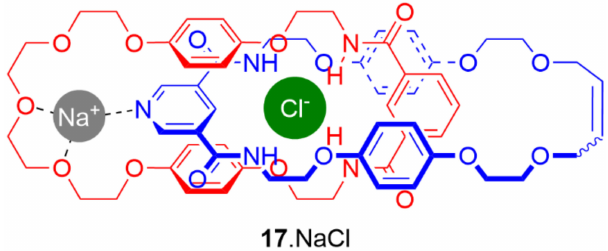
Figure 13. Evans and Beer’s neutral pyridyl catenane 17 that serendipitously exhibited ion pair binding in the solid state.